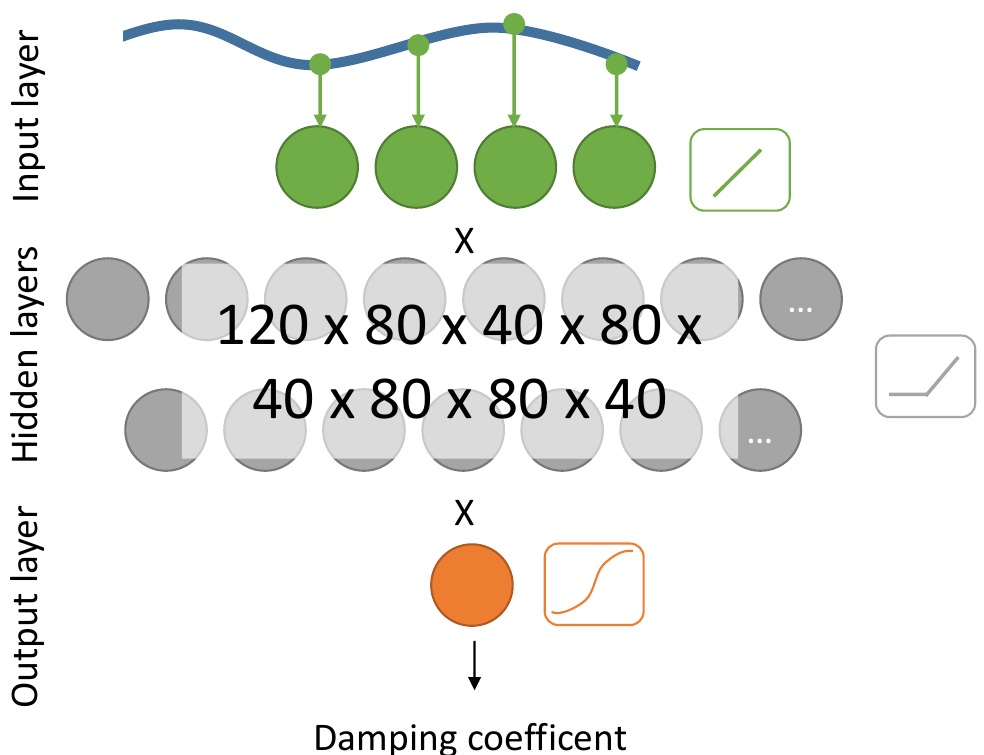
Figure 4. Number of layers and neurons for the collaborative learning network 1